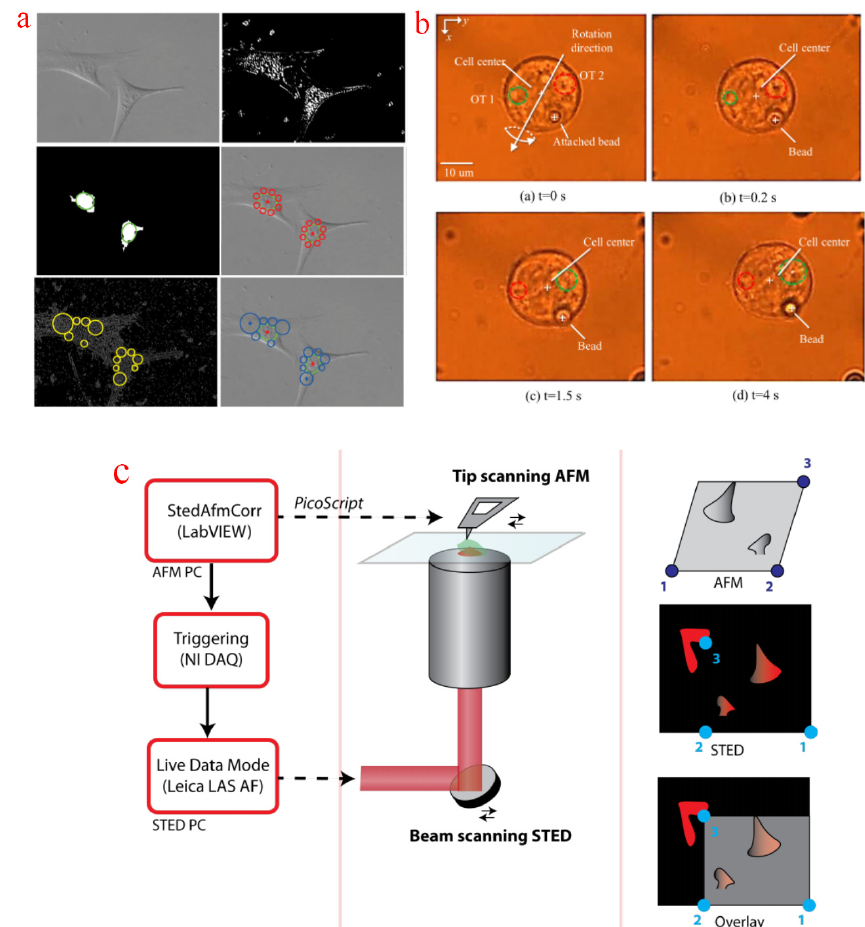
Figure 6. Feature points detection methods in micromanipulation tasks. ( a ) Nucleus and cytoplasm localization method based on K-means cluster and growing circles. Adapted with permission from Reference [128]; ( b ) Attached polybead for orientation control. Adapted with permission from Reference [132]; ( c ) AFM tip detection and its synchronization with STEDM. Adapted with permission from Reference